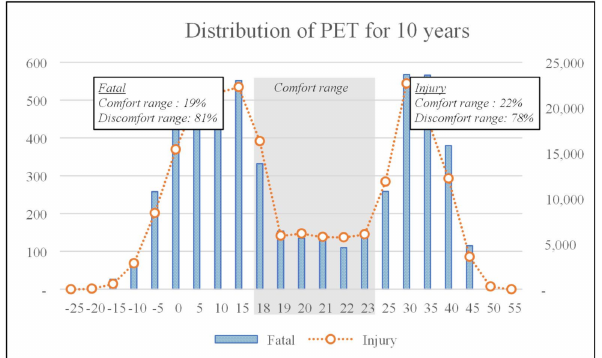
Figure 2. Distribution of the physiological equivalent temperature for 10 years.